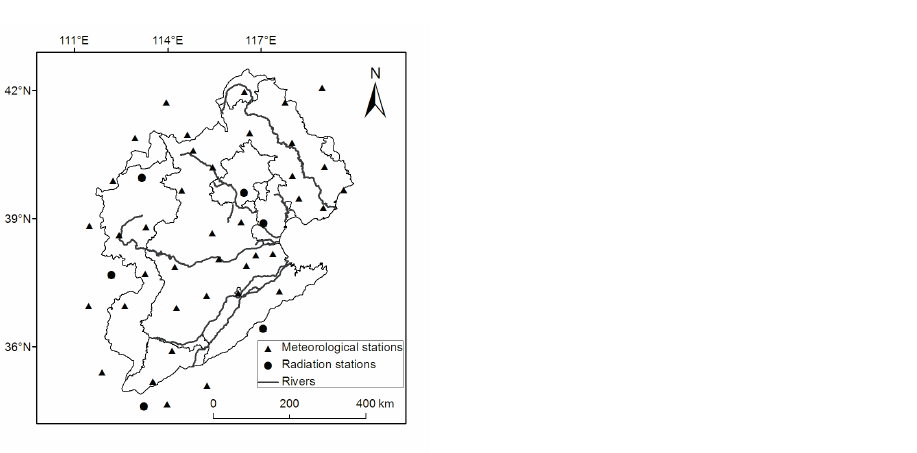
Fig. 1 Location of the 45 meteorological stations (six with radiation records) in Hai River